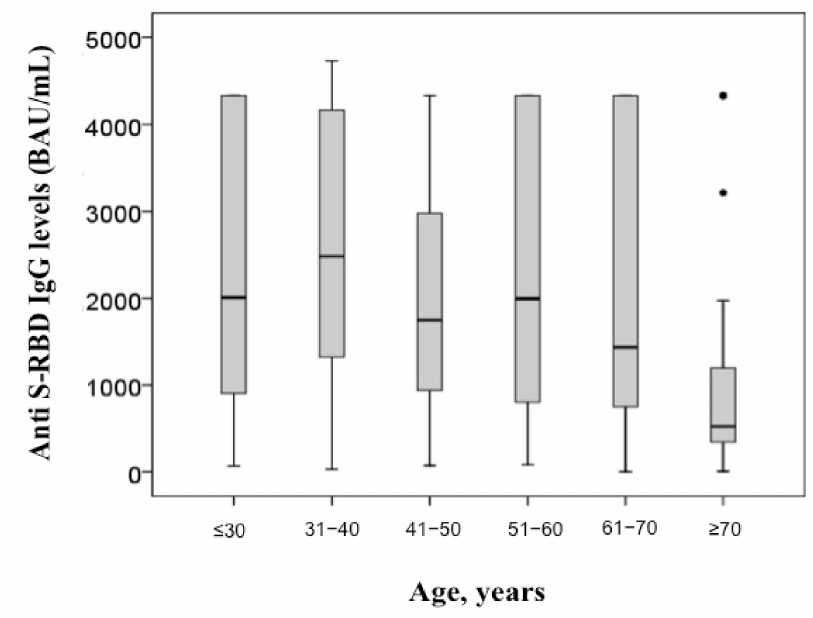
Figure 5. Anti S-RBD IgG levels in subjects sub-grouped by age. Subjects with anti-RBD IgG response tested at least two different time points after a complete two-dose cycle of vaccination were further evaluated. Change in anti S-RBD IgG response per day was calculated as [(RBDt1 − RBDt2)/RBDt1]/(t2 − t1), where RBDt1 and RBDt2 indicate anti S-RBD IgG levels at the two different time points, while t2 − t1 indicates time interval in days between blood